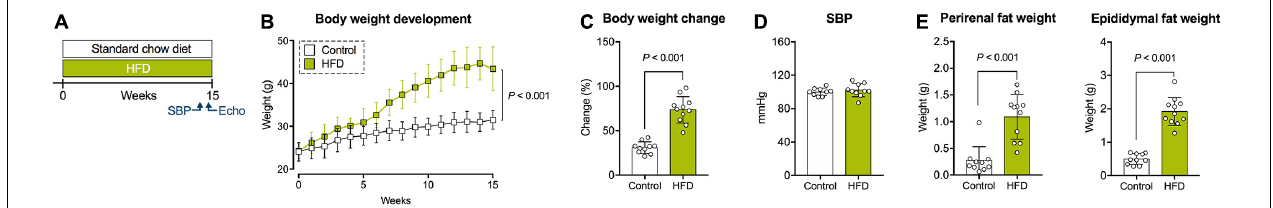
FIGURE 1 | Study protocol and physiological measures. (A) Study protocol. (B) Body weight development during the study period. (C) Relative body weight change from baseline to final assessment. (D) Systolic blood pressure (SBP) at 14 weeks of dietary intervention. (E) Weight of perirenal and epididymal fat depots after 15 weeks of dietary intervention. Echo, echocardiography; SBP, systolic blood pressure. Mean ± SD; n = 10–11 per group; two-way repeated measures ANOVA (B) , unpaired Student’s t -test ( C,E , right panel), or Mann-Whitney U test ( E , left panel).